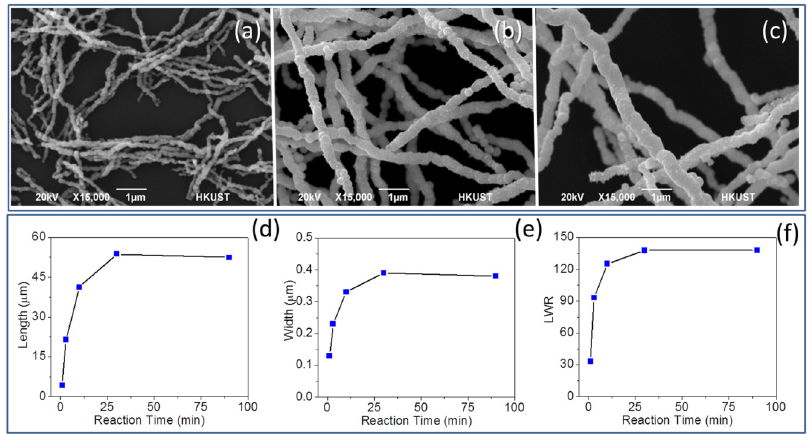
Figure 3. Typical SEM images with same magnification of NiNWs synthesized with ( a ) 1 min, ( b ) 10 min, and ( c ) 90 min. The change of ( d ) length, ( e ) width, and ( f ) LWR of NiNWs with reaction time.